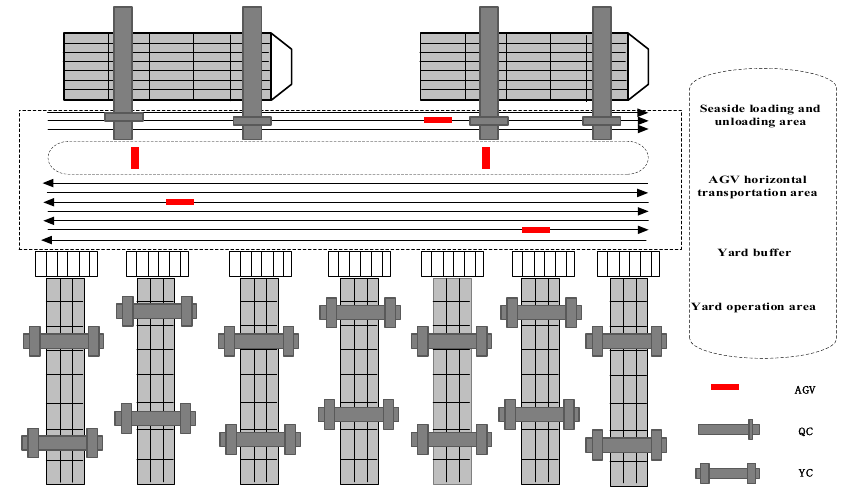
Figure 1. The layout of the automated container terminal is shown in the